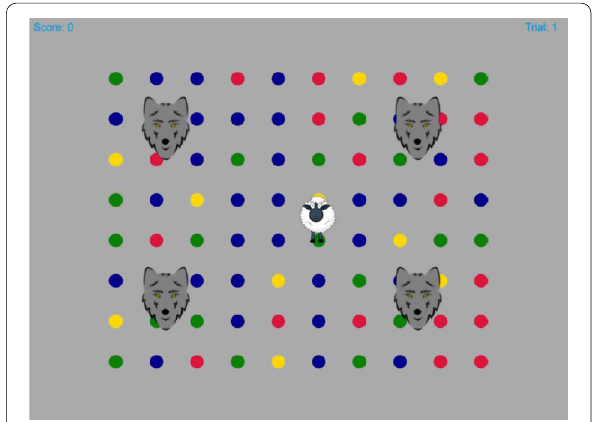
Fig. 1 Screenshot of The Predation Game. See text for